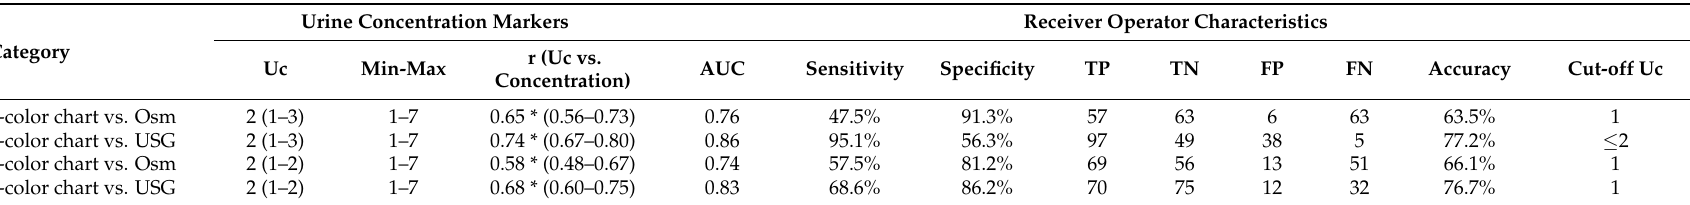
Table 2. Urine color scores, urine concentrations, AUC, accuracy of classification, and receiver operating characteristics (ROC)-based Uc cut-off values scored by participants based on n = 189 urine samples for two different Uc